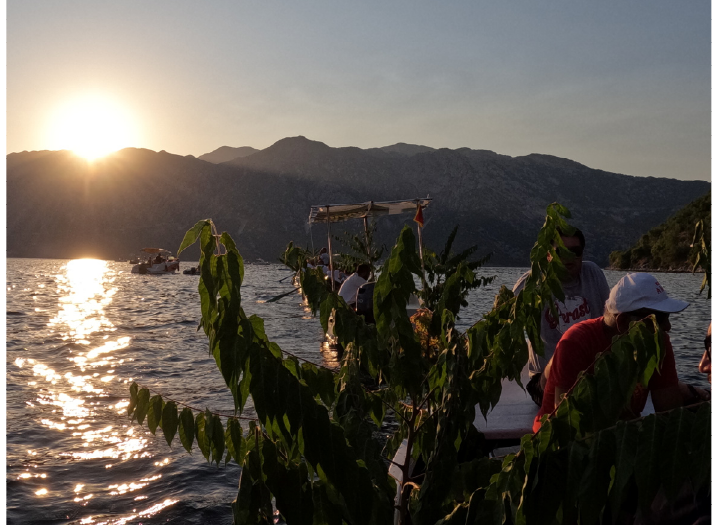
Figure 5. In the procession in 2022. Photo by the author.